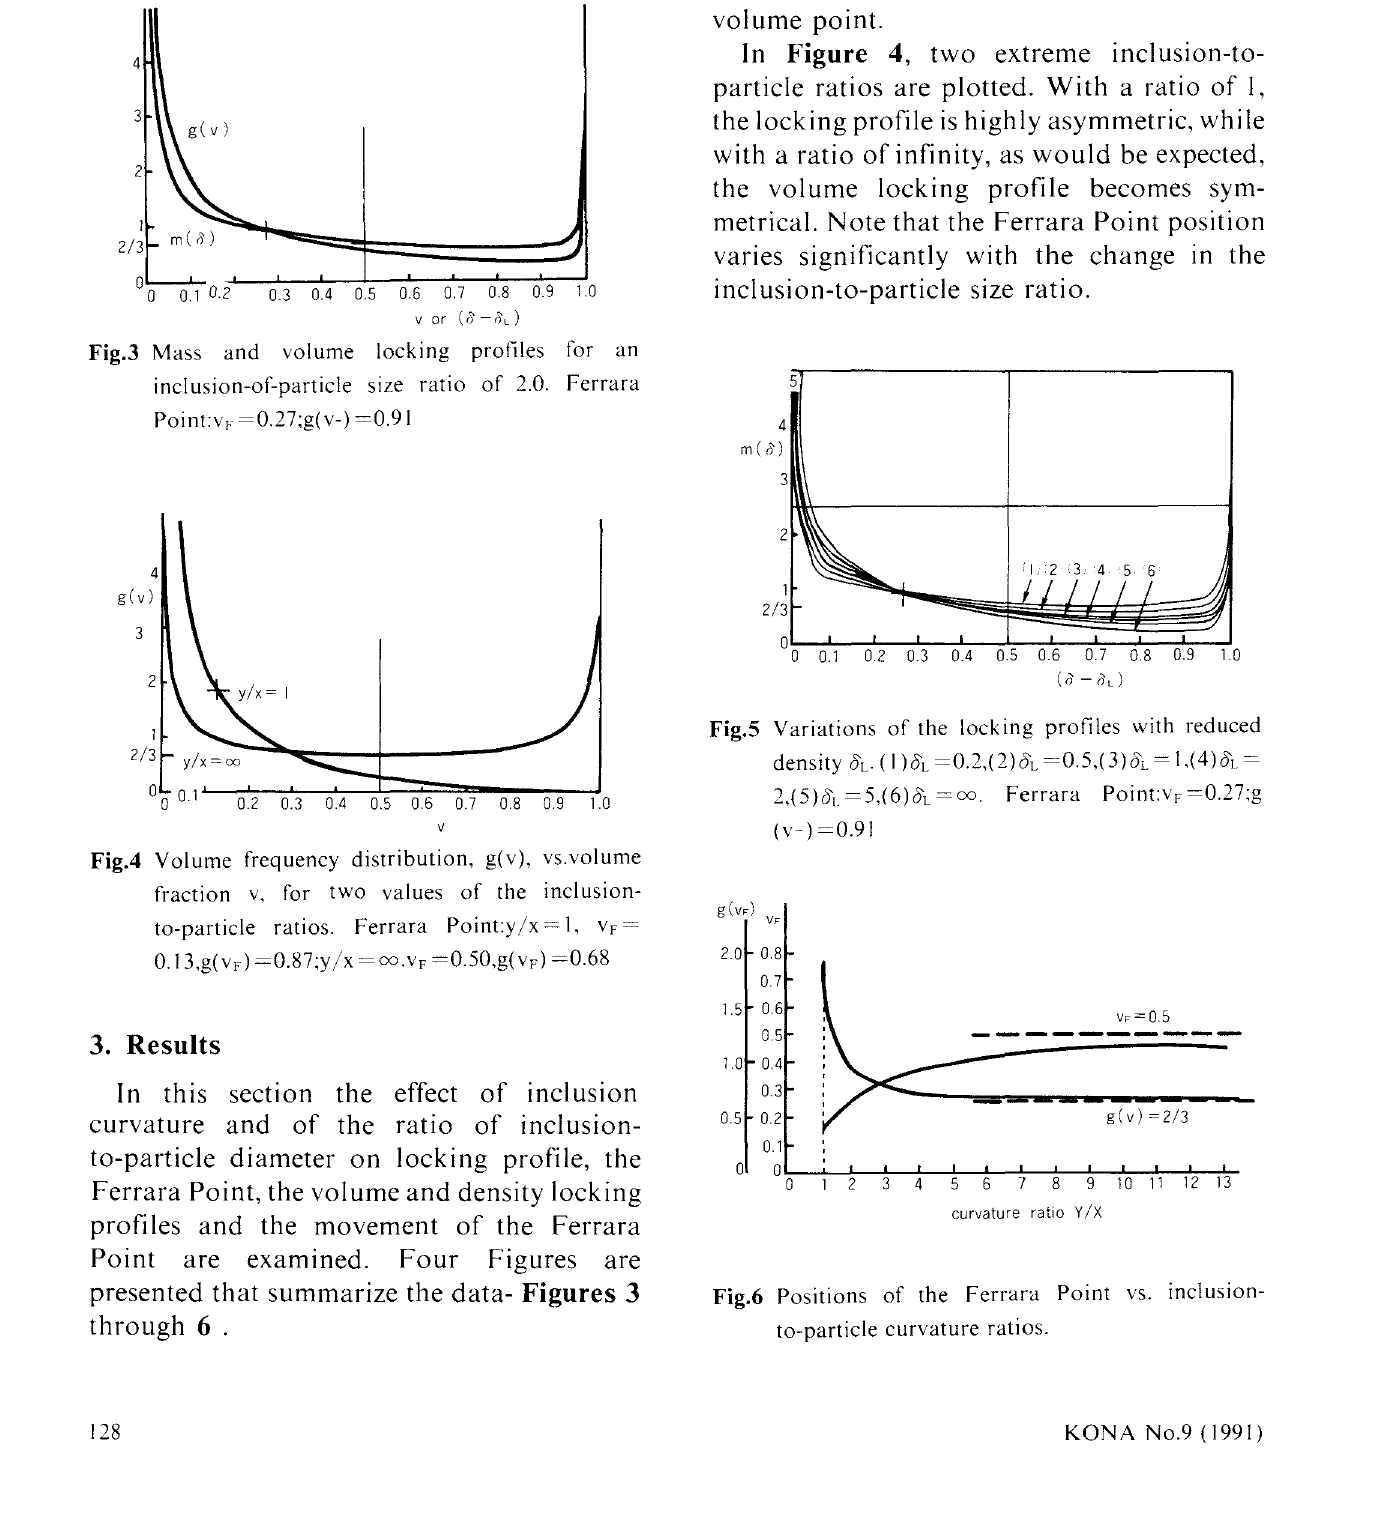
Fig.3 Mass and volume locking profiles for an inclusion-of-particle size ratio of 2.0. Ferrara Point:vF =0.27;g(v-) =0.91